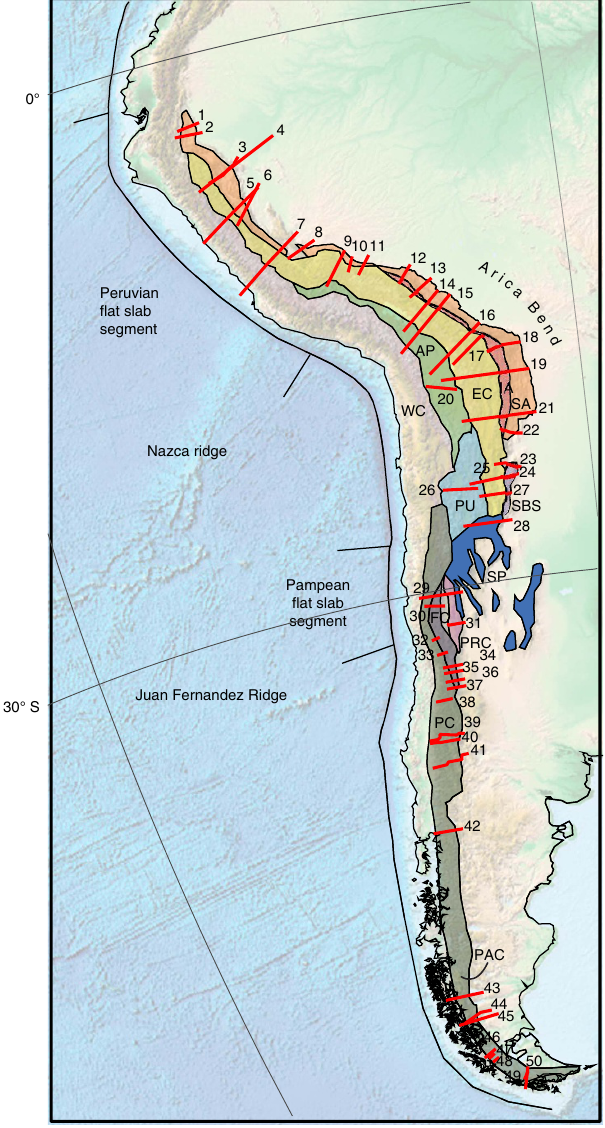
Figure 1 | Tectonic map. 3D Globe projectionof the Andes 29 , showing the boundaries of deforming geomorphologic regions, flat slab segments and ridges as discussed in this paper. AP, Altiplano Plateau; EC, Eastern Cordillera; FC, Frontal Cordillera; IA, Interandes; PAC, Patagonian Cordillera; PC, Principal Cordillera; PRC, Precordillera; PU, Puna Plateau; SA, Subandes; SBS, Santa Barbara System; SP, Sierras Pampeanas; WC, Western Cordillera. Numbered red lines indicate balanced cross sections; numbers refer to entries in Supplementary Table